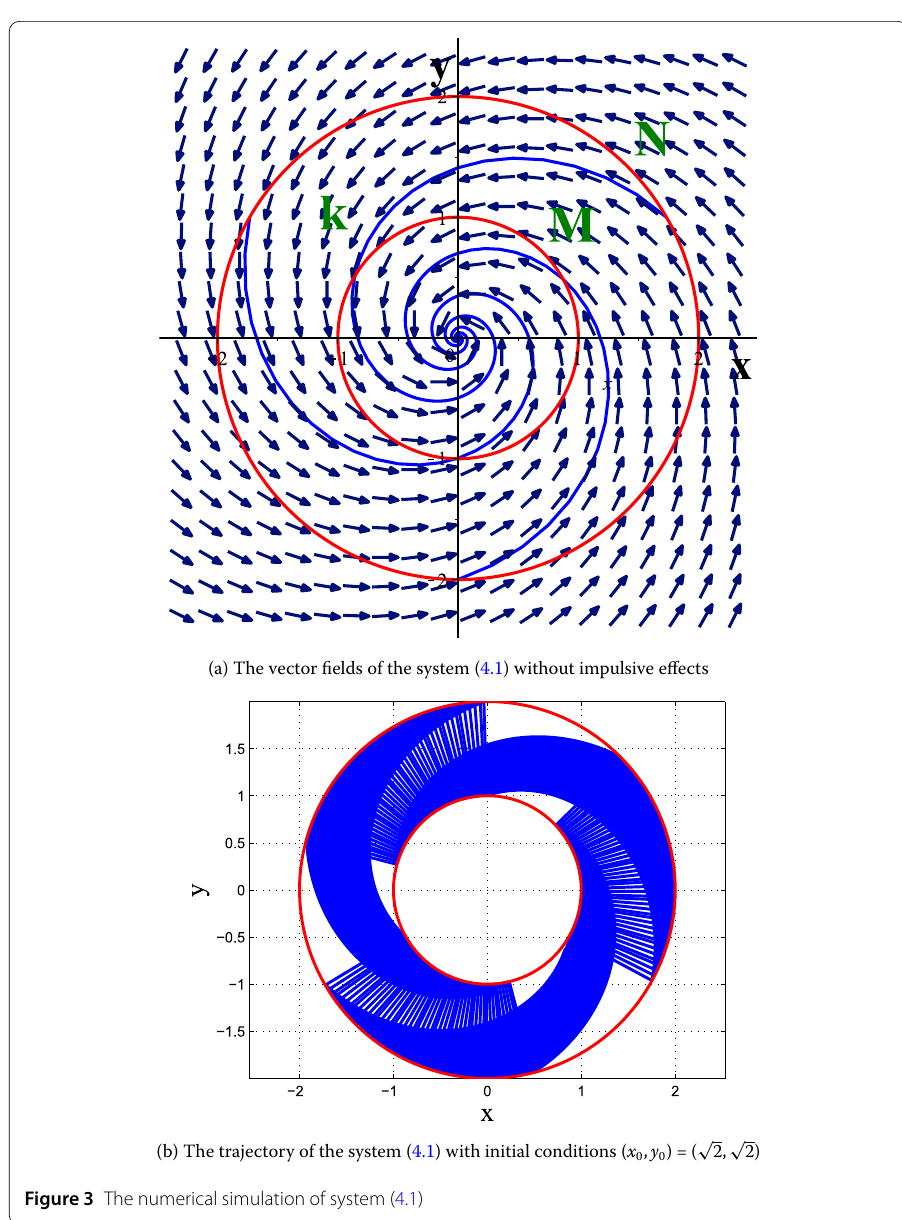
Figure 3 The numerical simulation of system